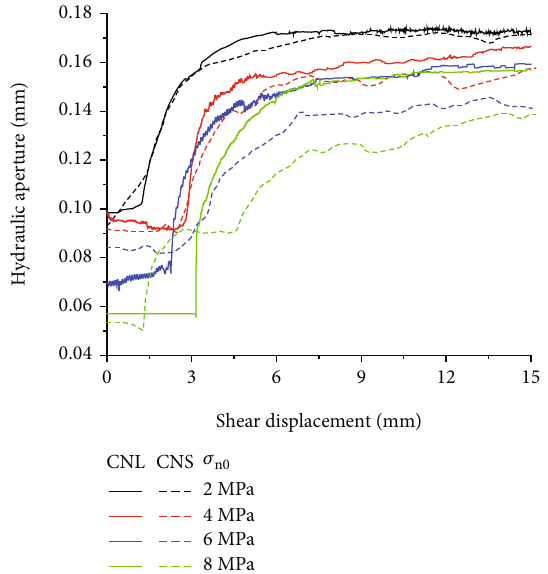
Figure 11: Curves of hydraulic aperture with shear displacement.